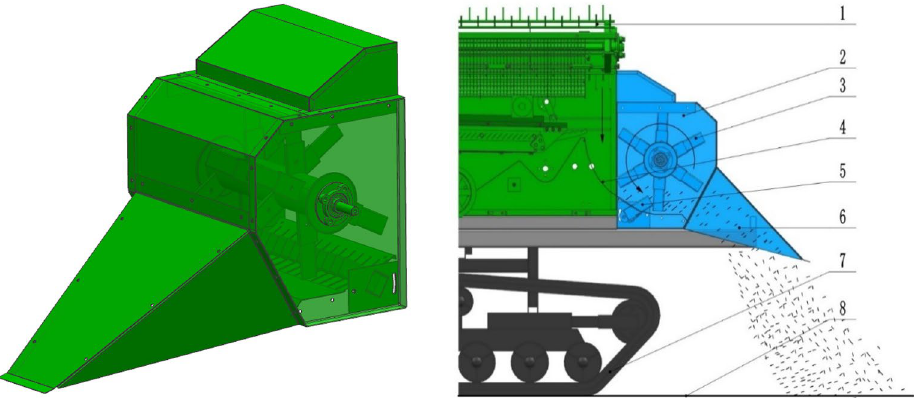
Figure 2. Structure and schematic diagram of smashing and scattering device. ( 1 ) threshing cylinder, ( 2 ) main box of the smashing and scattering device, ( 3 ) moving knife roller, ( 4 ) arc straw catching plate, ( 5 ) fix knife set, ( 6 ) straw deflector, ( 7 ) chassis, ( 8 ) ground. (SolidWorks 2020, https:// www. solid works. com/ zh-